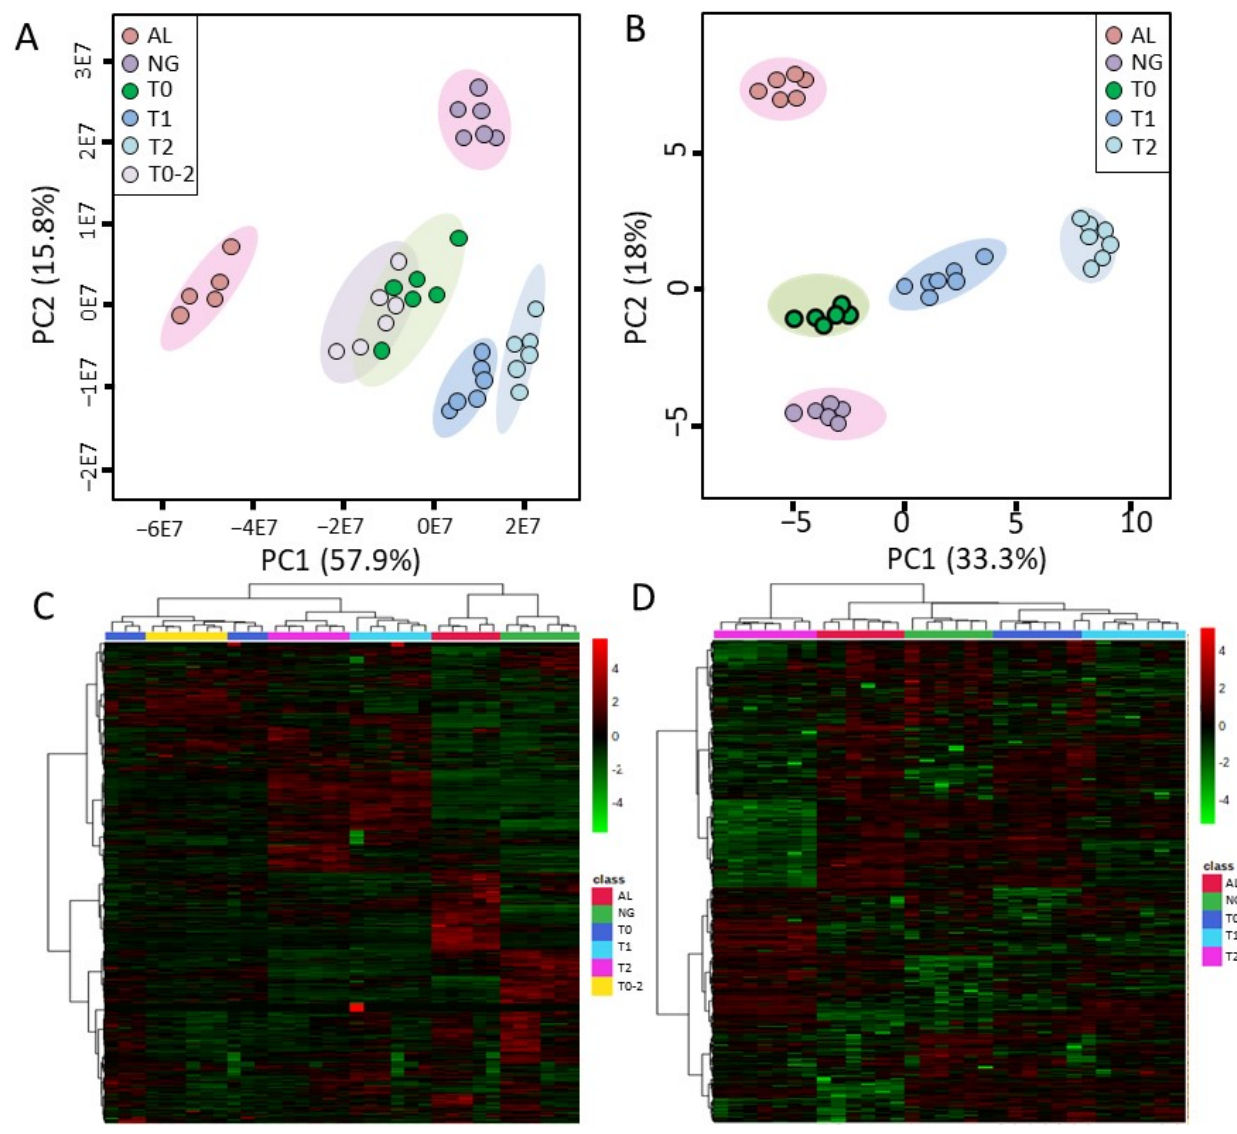
Figure 2. PCA score plot ( A , B ) and heatmap ( C , D ) of tea samples based on the relative variation of all compounds detected by the LCMS-semipolar platform ( A , C ) and all compounds detected by the GCMS-polar platform ( B , D ) using tea leaves cultivated for 30 days at 25 °C (NG) or 15 °C (AL), and for 0 (T0), 3 (T1) and 6 (T2) days after starting greening. The same shoots from plants treated at 15 °C were harvested as the control group at day 6 (T0-2).